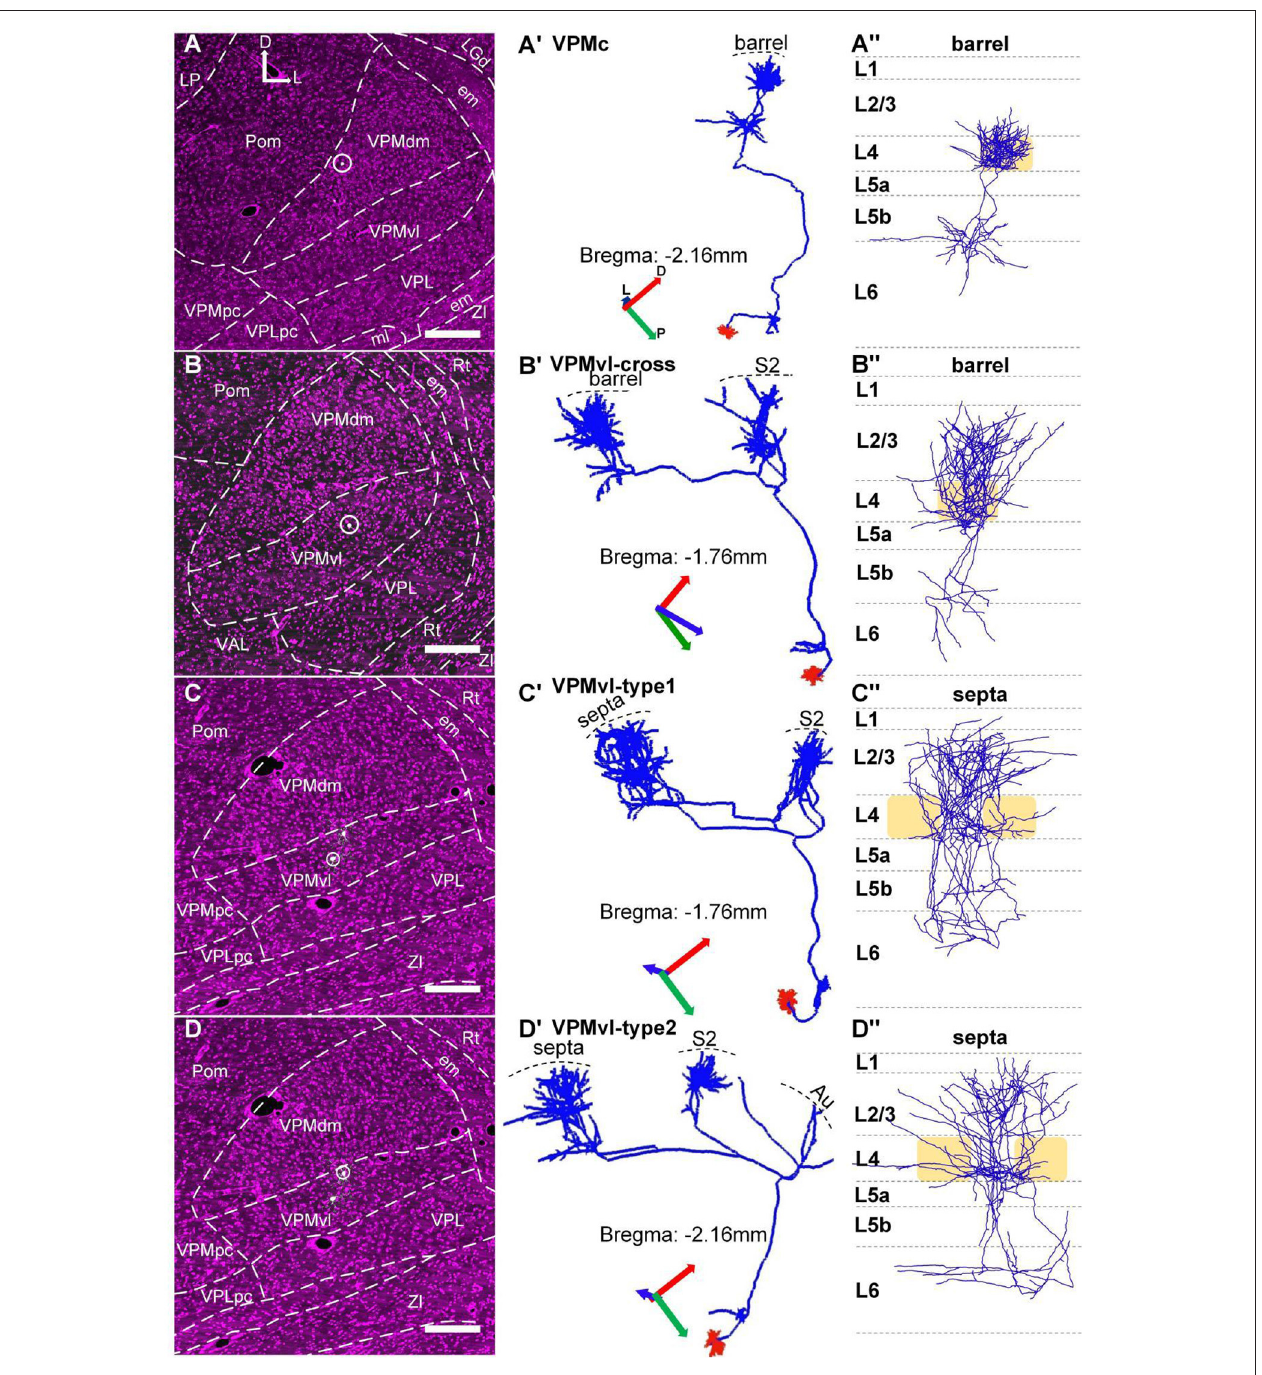
FIGURE 3 | Topographic organization of VPM thalamocortical projections. (A–A”) The thalamocortical projection area of the typical VPMc neuron is a barrel column. (B–B”) Thalamocortical projection areas of VPMvl-cross neuron are barrel column and S2. (C–C” ) Thalamocortical projection areas of VPMvl-type1 neuron are septa and S2. (D–D”) Thalamocortical projection areas of VPMvl-type2 neuron are septa, S2, and Au. (A–D) The VPM neuron soma location. White dots in white circle: soma bodies. (A’–D’) The whole 3D morphology of VPM neuron. All project to Rt nuclei in subcortex. Blue lines: axons. Red lines: dendrites. (A”–D”) Axon distribution in barrel columns and septal areas. Light yellow box: barrel. The previous report naming convention is adopted, which relates the projection pattern to the cell body location in VPM. D, Dorsal; P, Posterior; L, Lateral.